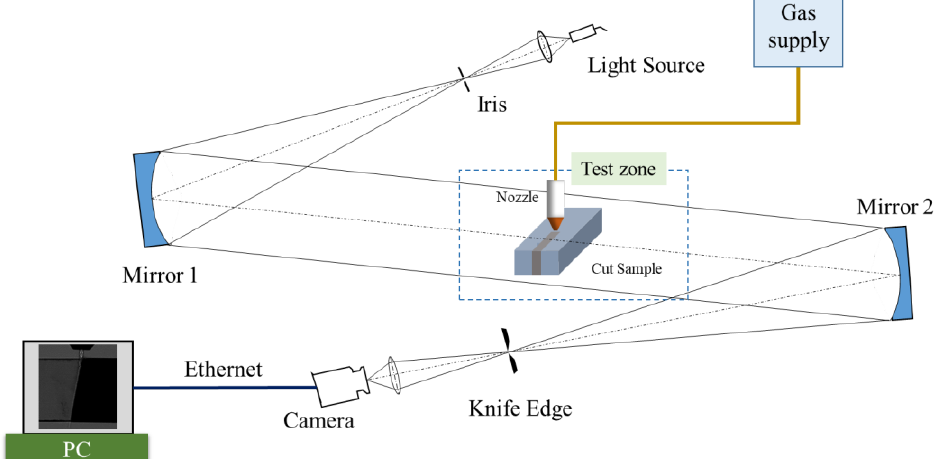
Figure 3. Schematic diagram of Schlieren